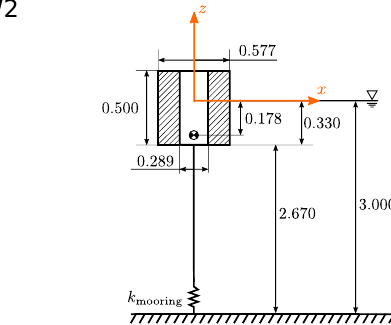
Figure 3. Schematic (not at scale, all dimensions in [m]) and photograph of ( a ) WEC structure 1 and ( b ) WEC structure 2. Table 1. Inertial properties and the vertical location of the CoM for the sensitivity